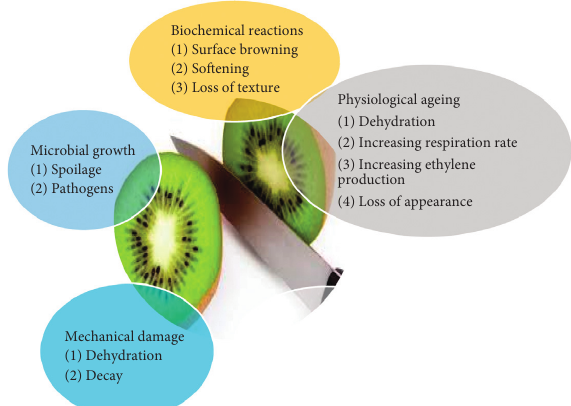
Figure 2: Effect of minimal processing on the decay and shelf-life of fresh